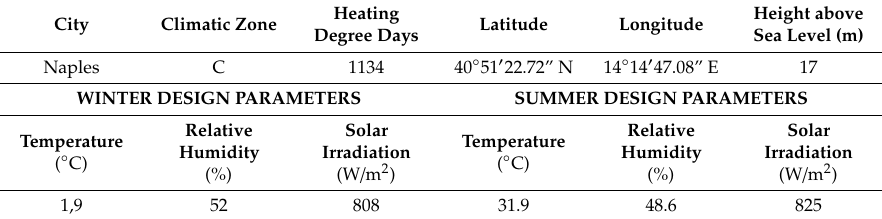
Table 1. Winter and summer external design parameters for Naples [43].